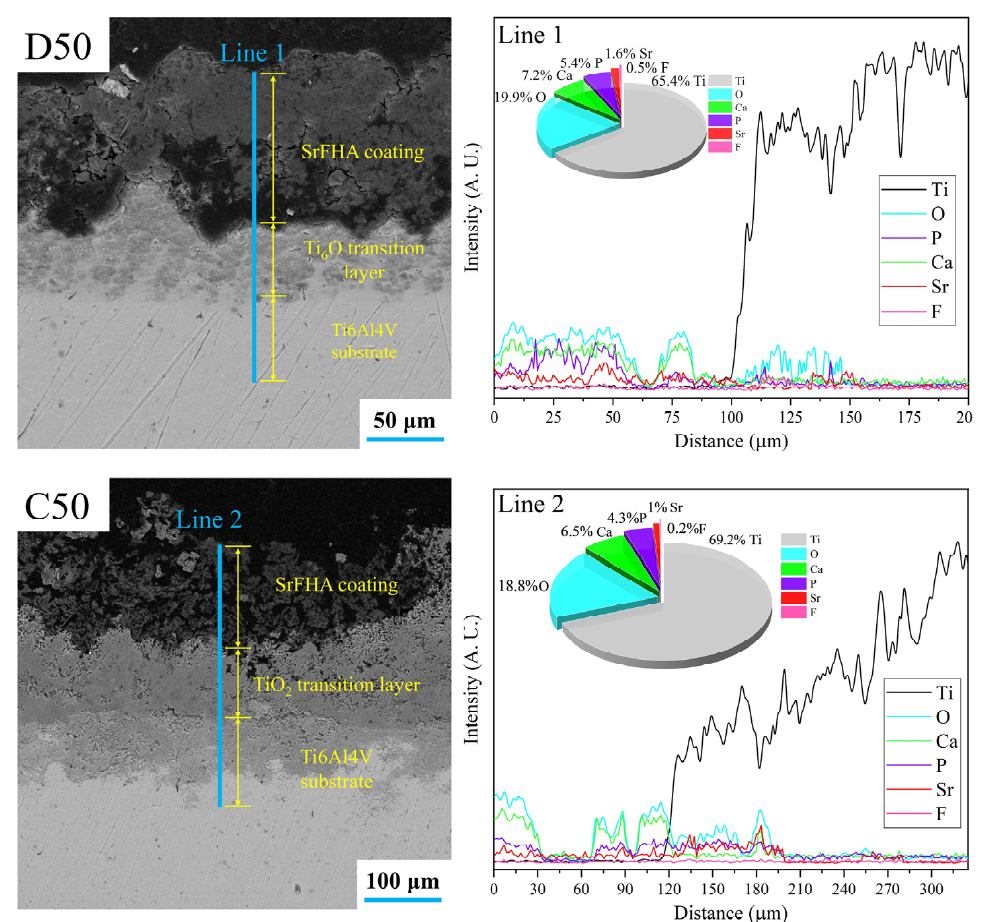
Figure 9. SEM images and EDS line scan analyses of cross-sections of coatings of the deposition product (D50) and calcination product (C50).